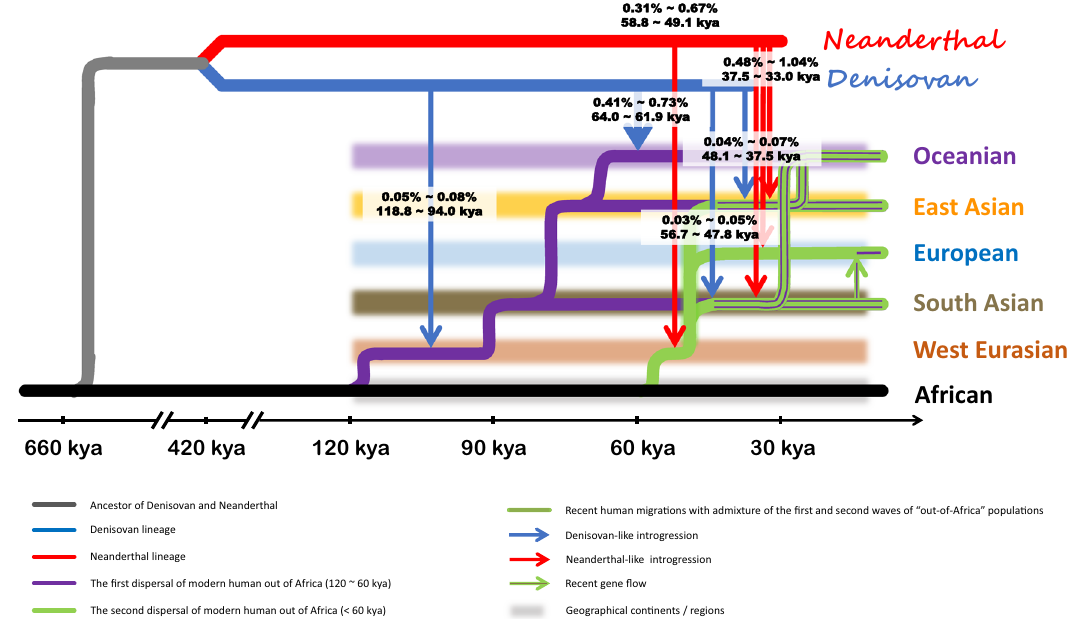
Fig. 6 The landscape of prehistoric human dispersal and archaic introgression in Eurasia and Oceania . The brown lines represent the lineages of the fi rst-wave “ Out of Africa ” migration, the green line represents the second-wave “ Out of Africa ” migration, and the brown-green line represents the lineages admixed by the two-wave “ Out of Africa ” migration. Red arrow lines represent the Neanderthal-like introgression events and blue arrow lines represent the Denisovan-like introgression events. Shadow areas of different colors stand for different